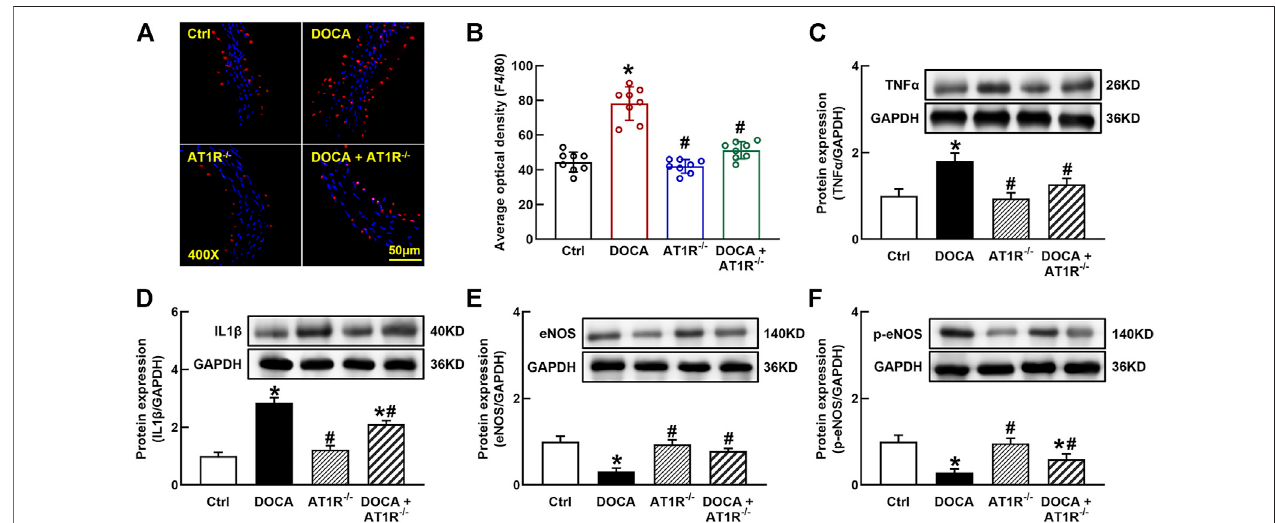
FIGURE 9 | Myeloid AT1R gene de fi ciency reduced macrophage in fi ltration and vascular in fl ammation in DOCA/salt hypertensive mice. Representative images of aortic F4/80 expression assessed by immuno fl uorescence staining (A) ; quantitative analysis of average immuno fl uorescence intensity of F4/80 expression (B) ; protein expressions of proin fl ammatory cytokines, TNF α (C) and IL-1 β (D) , in the aorta; protein expression of eNOS (E) and p-eNOS [Ser 1177, (F) ] in the aorta. Statistical comparisons were carried out with two-way ANOVA followed by the Tukey post hoc test. Datawere expressed as mean ± SEM. N = 8, * p < 0.05 vs. control mice. # p < 0.05 vs. DOCA